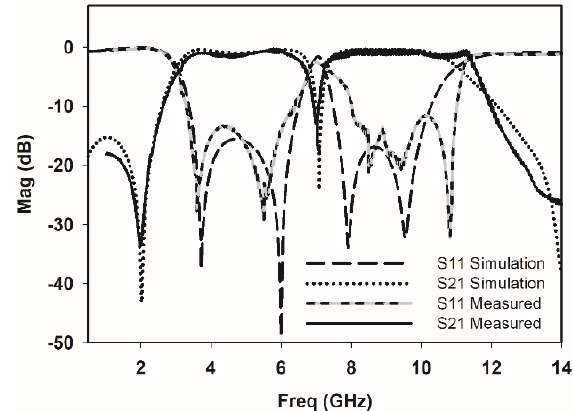
FIGURE 12. Simulated and measured S-parameters of the proposed